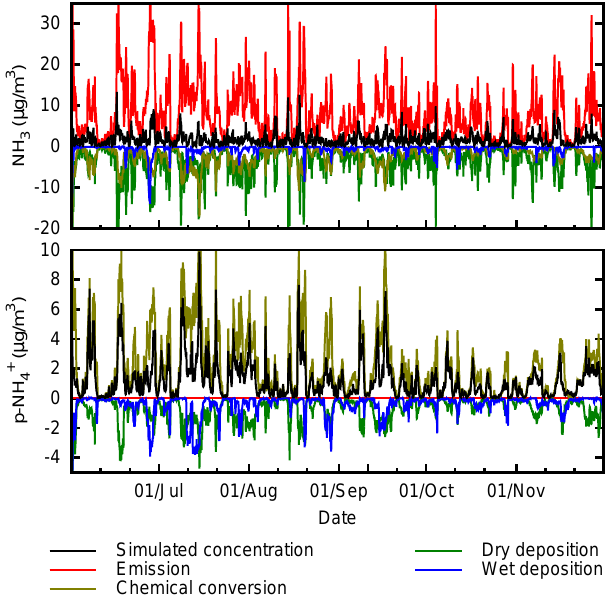
Fig. 9. Simulated NH 3 (top) and p -NH + (bottom) concentrations 4 (black) at Egbert, compared against modeled contributions or losses from emission (red), dry deposition (green), wet deposition (blue), and chemical conversion (olive) for the entire simulation